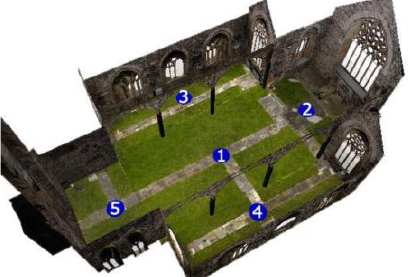
Figure 7 Locations of five spherical panoramas.